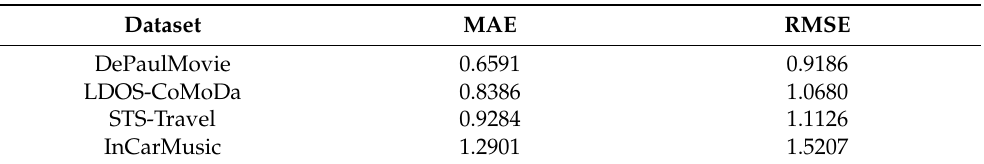
Table 11. Accuracy of the CBMF methods on the datasets DePaulMovie, LDOS-CoMoDa, STS-Travel, and InCarMusic.